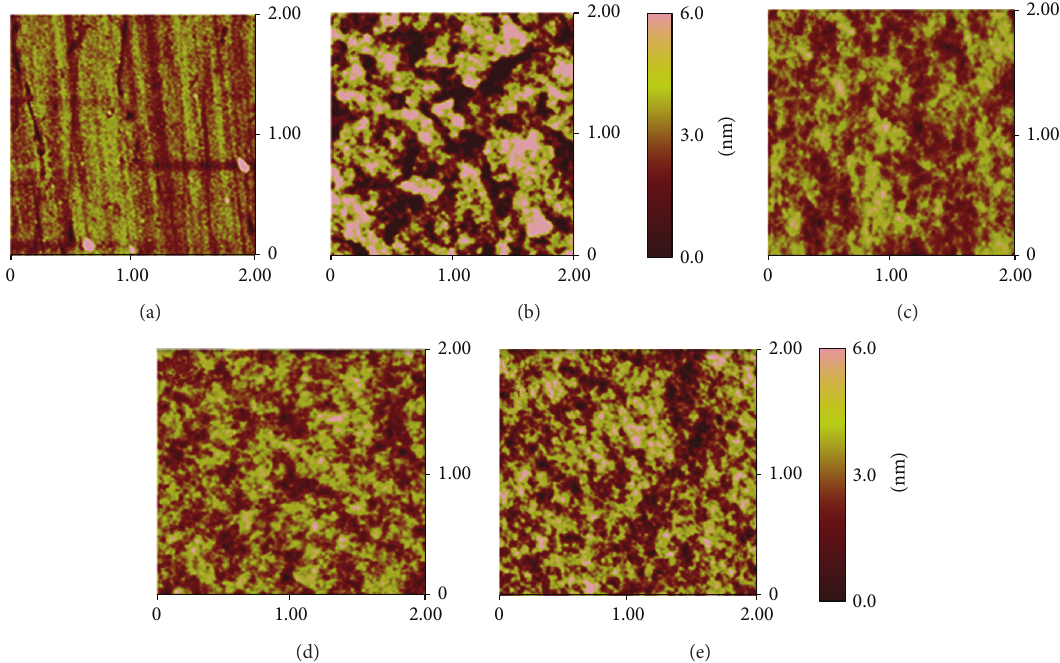
Figure 8: AFM images of different PEDOT:PSS devices. (a) Only PEDOT:PSS solution on ITO at the speed of 3000 rpm. (b) The PEDOT:PSS and DMAC mixed in a ratio of 4 :1(v/v) at the speed of 3000 rpm. (c), (d), and (e) The PEDOT:PSS buffer layer modified by DMAC at speeds (1000, 3000, and 5000